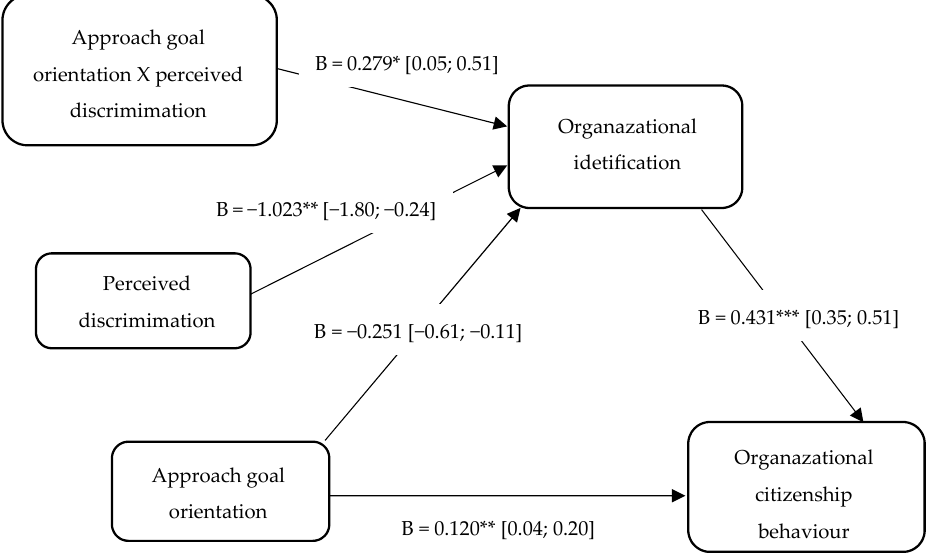
Figure 1. Results of the moderated mediation analysis. The relationship between approach goal orientation and organizational citizenship behavior (OCB) through organizational identification was moderated by perceived discrimination. Note: * p < 0.05. ** p < 0.01. *** p <